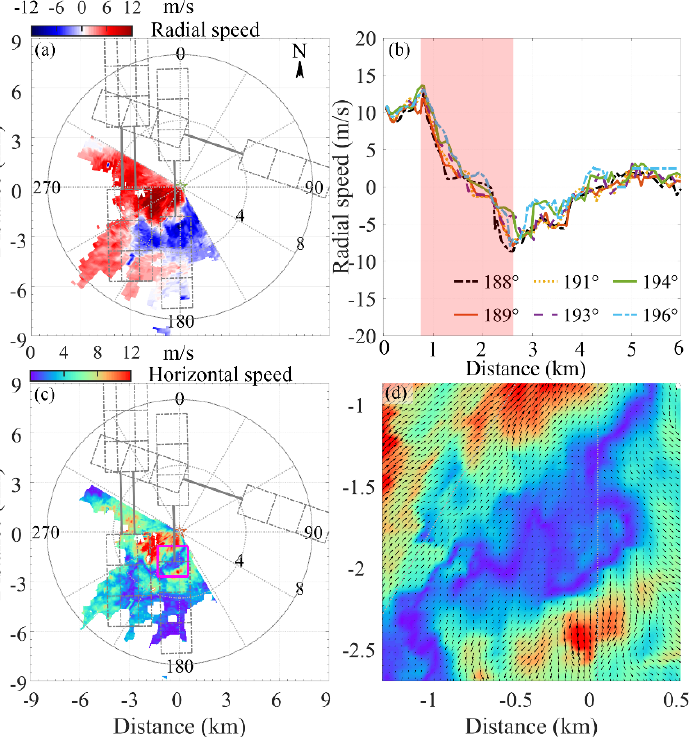
Figure 4. Microburst results detected by the CDWL on 28 April, 15:54:12–15:54:42 (UTC). ( a , b ) radial speed, ( c ) horizontal speed. The pink rectangle means the area most affected by microburst. The detail structure of horizontal speed in pink rectangle in ( c ) is shown in ( d ). The sign of radial speed is defined as positive when the movement is toward the lidar, and vice versa.